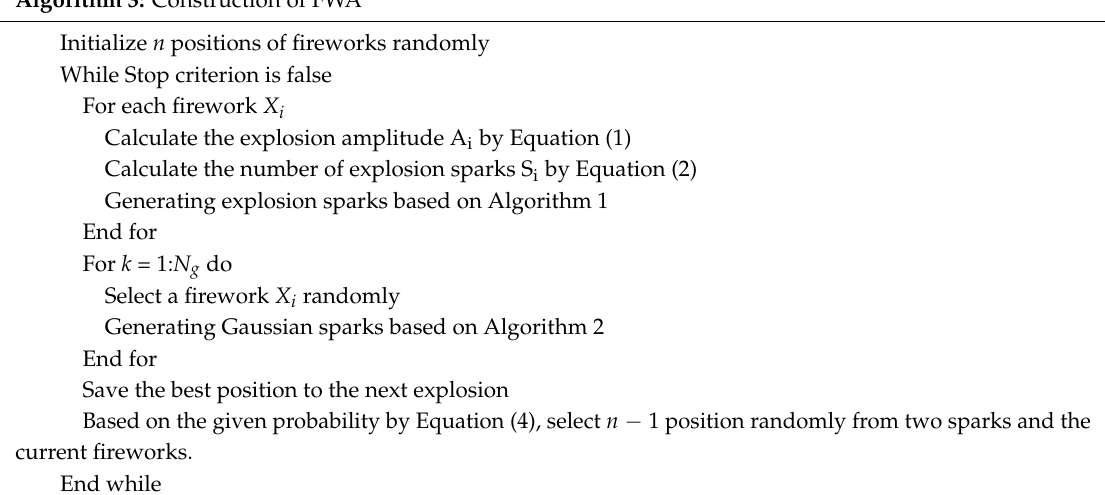
Algorithm 3: Construction of FWA